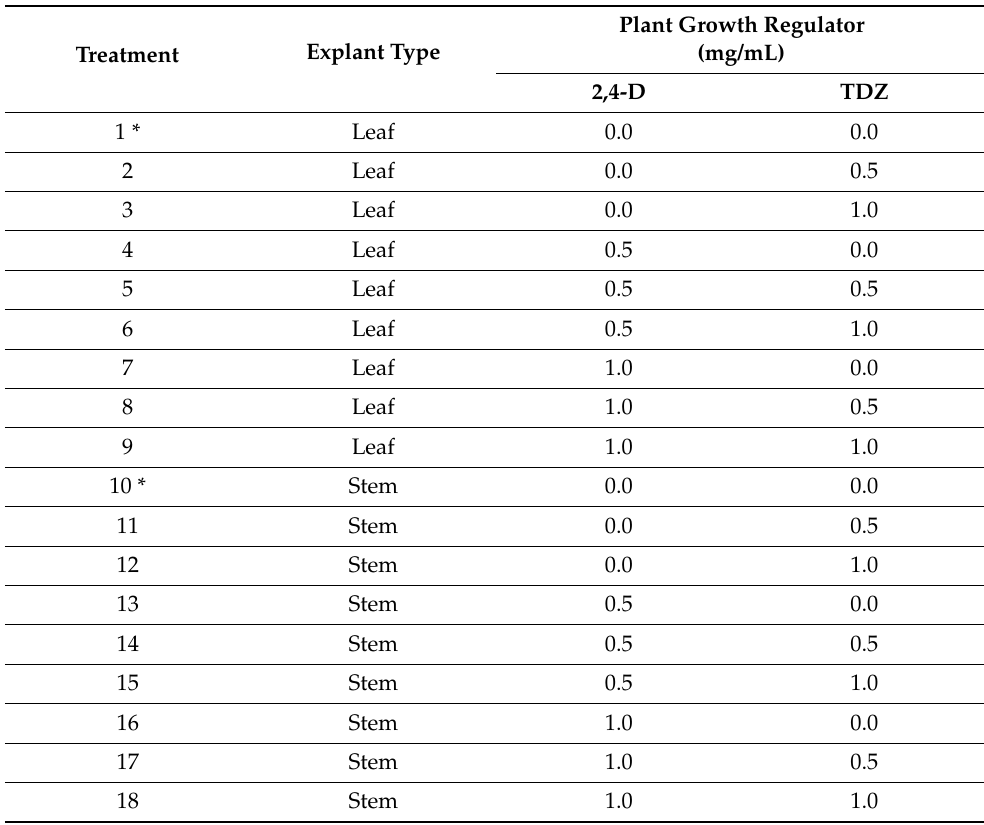
Table 6. Multifactorial experimental design to evaluate the response of the type of Sideroxylon capiri Pittier explant and the type of growth regulator on the callus formation index (CFI).